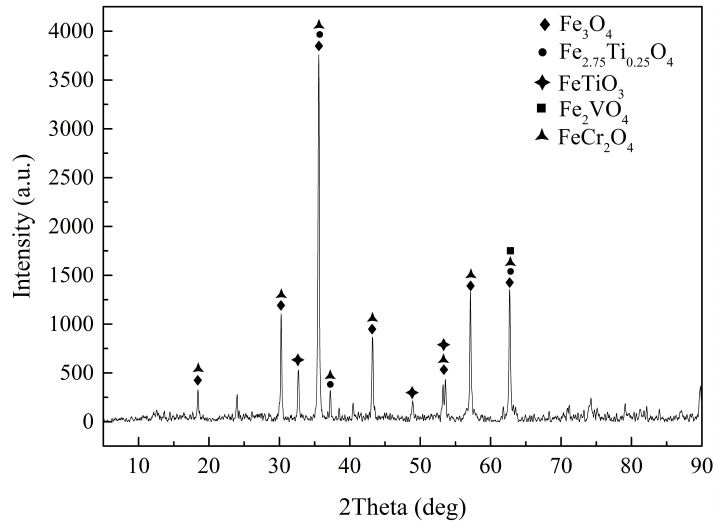
Figure 3. XRD pattern of CVTM ore. Table 6. ICSD card numbers of phases in CVTM.